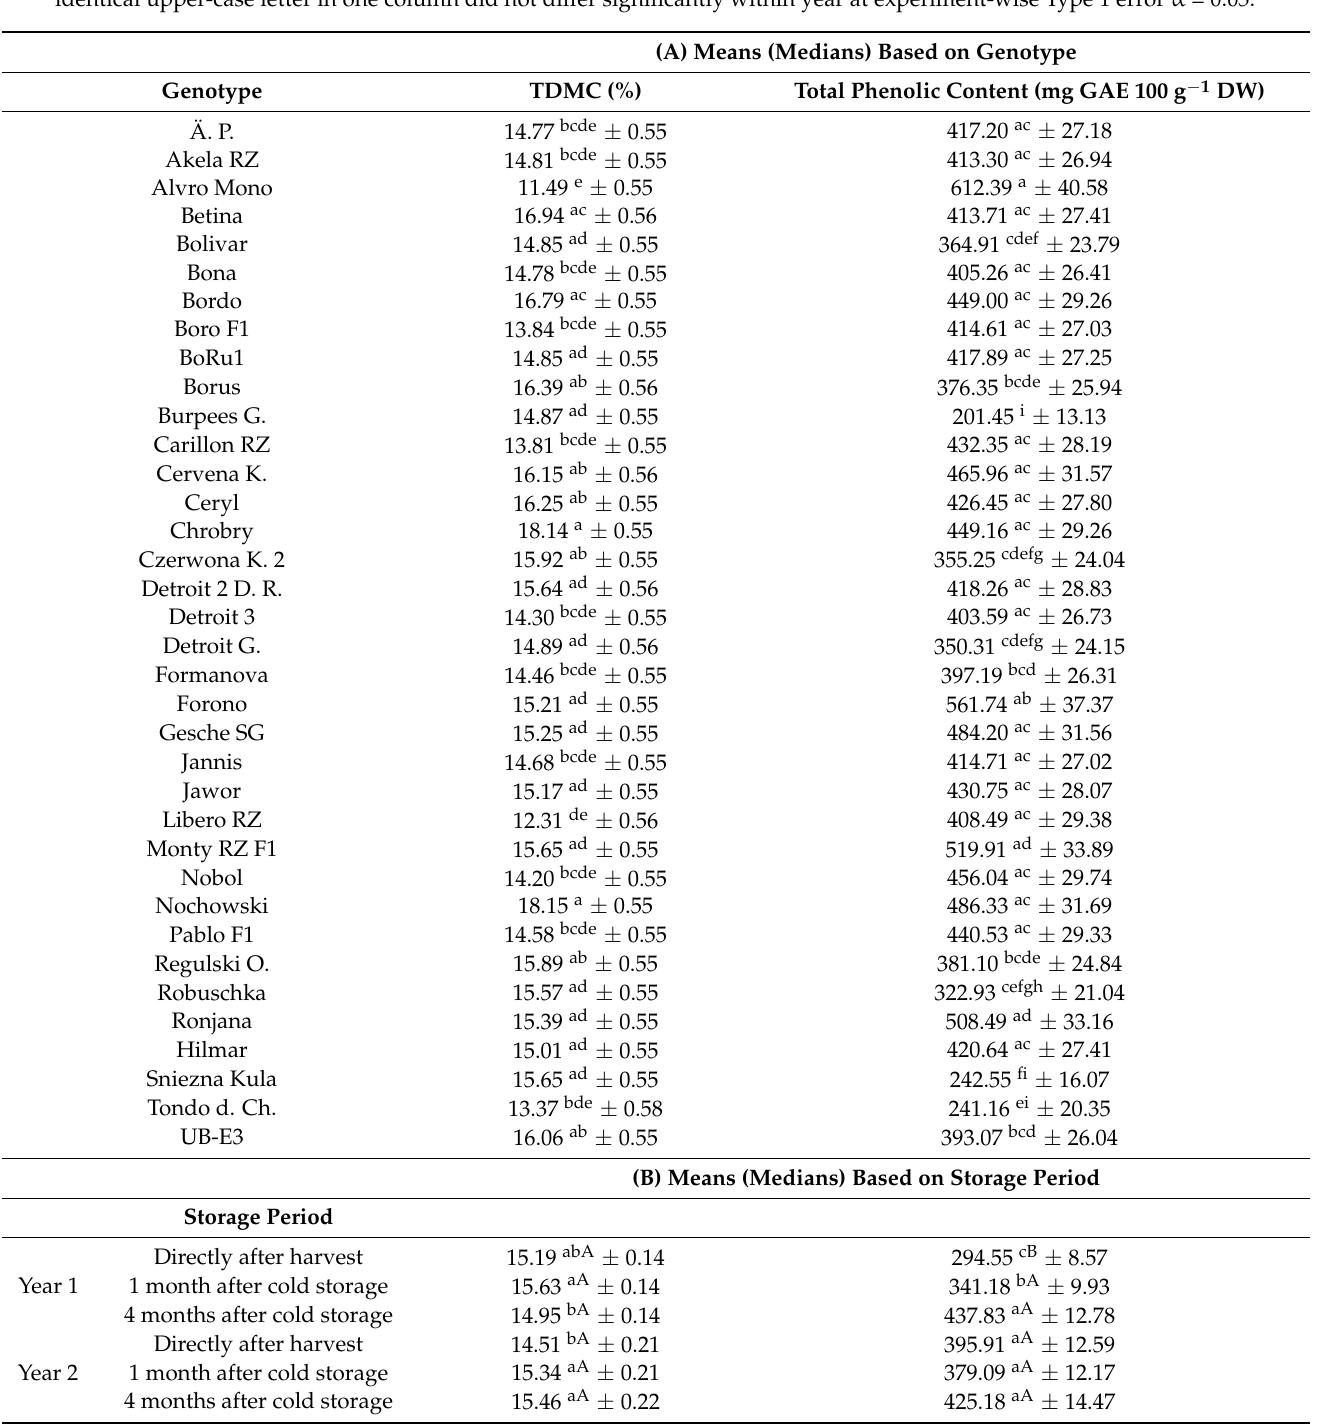
Table 3. Mean and median values of total dry matter content (%) and total phenolic content (mg GAE 100 g − 1 DW) of 36 beetroot genotypes grown at the research station Kleinhohenheim within the years 2017 and 2018. Results represent the mean (median) values ± (approximate) standard error. In section (A), means (medians) followed by at least one identical lower-case letter in one column did not differ significantly between genotypes at experiment-wise Type 1 error α = 0.05. In section (B), means (medians) followed by at least one identical lower-case letter in one column did not differ significantly within different storage periods at experiment-wise Type 1 error α = 0.05 and means (medians) followed by at least one identical upper-case letter in one column did not differ significantly within year at experiment-wise Type 1 error α =